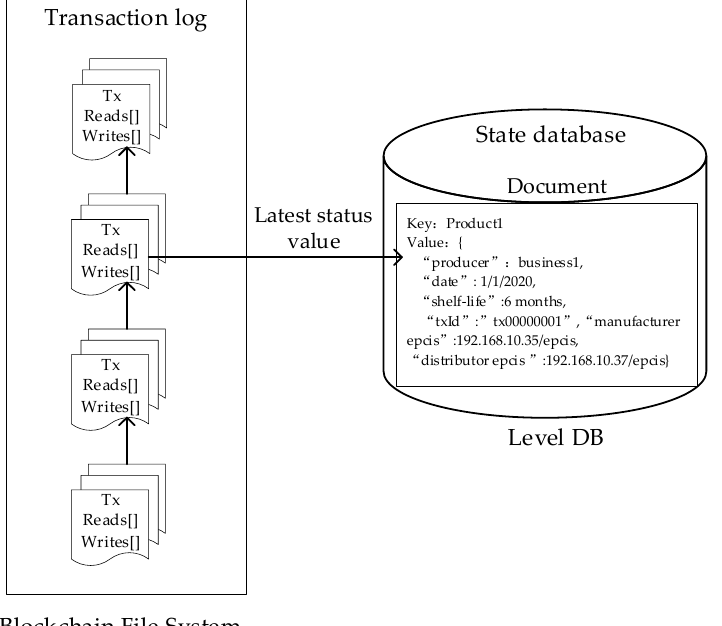
Figure 5. Schematic diagram of the implementation structure of the data storage and ledger.